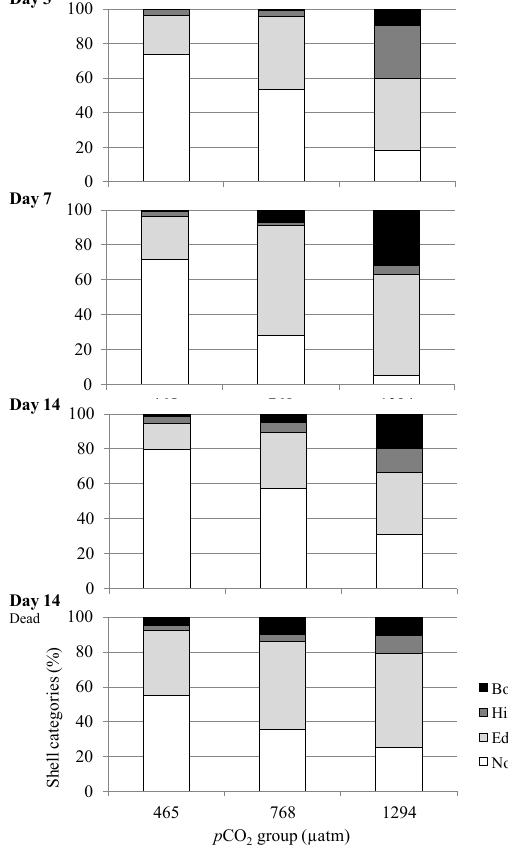
Figure 5. Larvae classified into four different shell categories: nor- mal , edge (deformities), hinge (deformities) and both (edge and hinge deformities) at three p CO 2 levels – 465 (ambient), 768 and 1294µatm – in live larvae at day 3, day 7, day 14, and in dead larvae at day 14. The figure is based on the sum of four replicates in each p CO 2